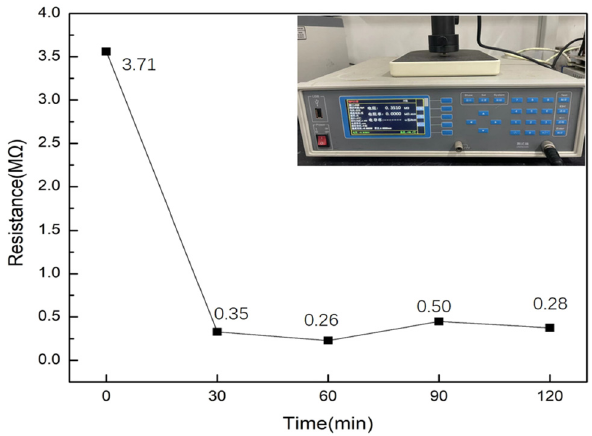
Figure 7: Micron - scale diamond fi lm square resistance value with hydrogen plasma etching